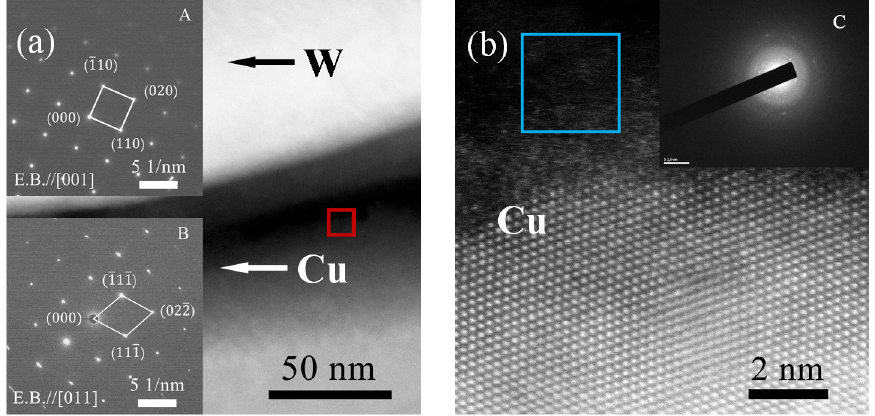
Figure 7. ( a ) HAADF-STEM image of the W/Cu interface through direct alloying at 980 °C; ( b ) Atomic resolution HAADF-STEM images of the region marked with a red rectangle in ( a ).